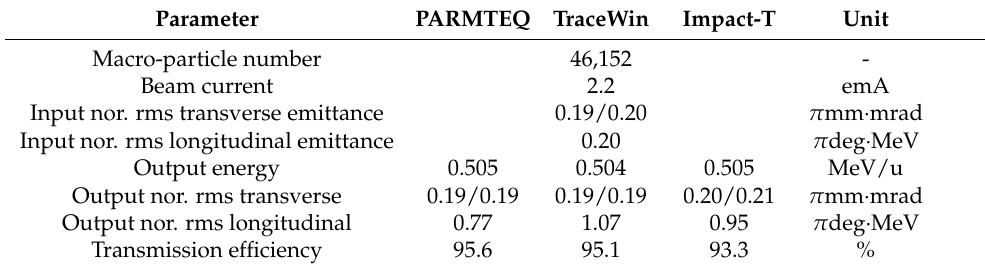
Table 2. Simulation results of the three software